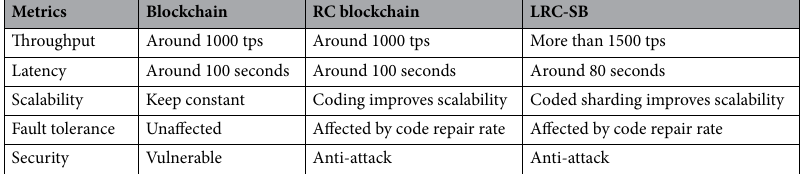
Table 4. Comparison of performance and efficiency of three kinds of